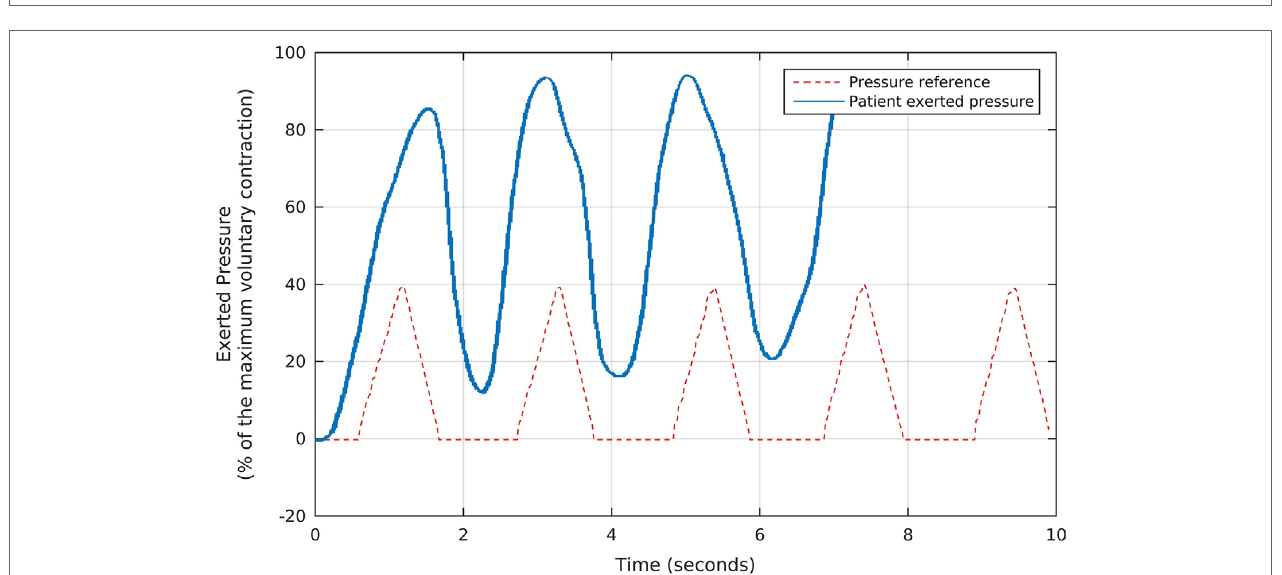
FIgURe 4 | The fast, triangular-shaped pressure waveforms used as the reference for each volunteer during the first stage of the biofeedback sessions, and the corresponding pressures exerted by a patient. We oriented each participant to try and reproduce the reference waveforms by exerting pressure over the anal probe, while watching the generated signals in real time. Note that, as requested, the patient tried to maintain the actual pressure values above the minimum reference, while following the basic triangular shapes.